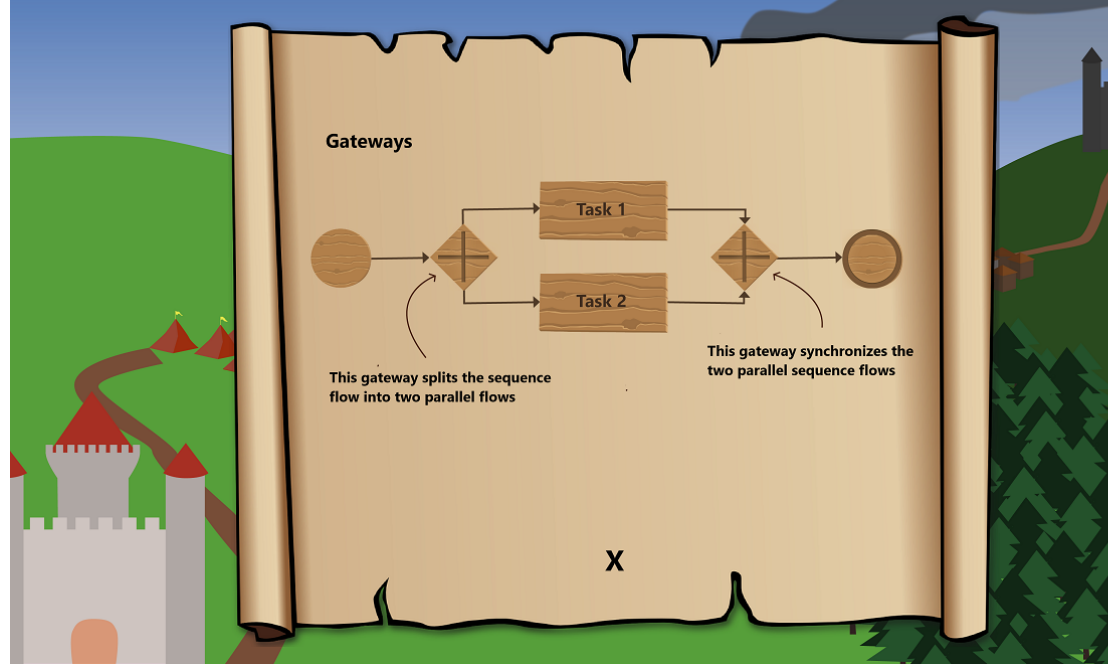
Figure 4. Troop and resource